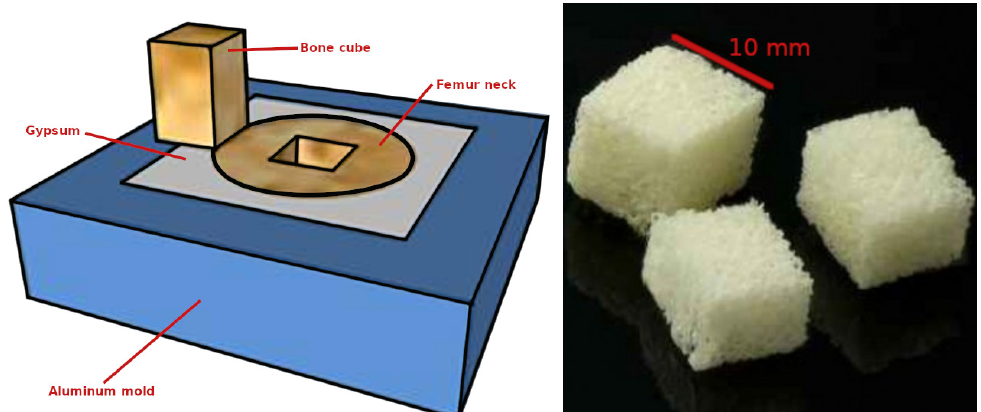
Figure 2. Representation of the machining process ( left ) and examples of the bone cubes ( right ). Note that only those bone cubes with 10 mm per side were used in this study, but smaller cubes were set aside for future